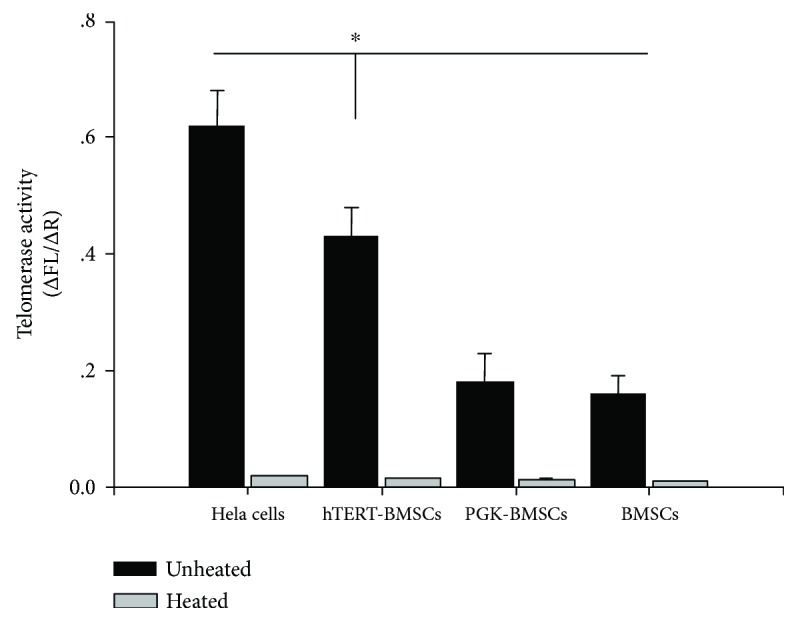
Telomerase activity of HeLa cells, BMSCs, PGK-BMSCs, and hTERT-BMSCs (TRAP assay) after disposed with or without heat. There was little telomerase activity in all heat-treated negative control cells; however, in unheated cells, despite extensive doublings, the immortalized cells (hTERT-BMSCs) displayed significantly higher telomerase activity than their primary counterparts and PGK-BMSCs, except the positive control cells (HeLa) and the telomerase activity of the immortalized population remained stable (assessed at P30). Significance level is P < 0.05, indicated by ∗.